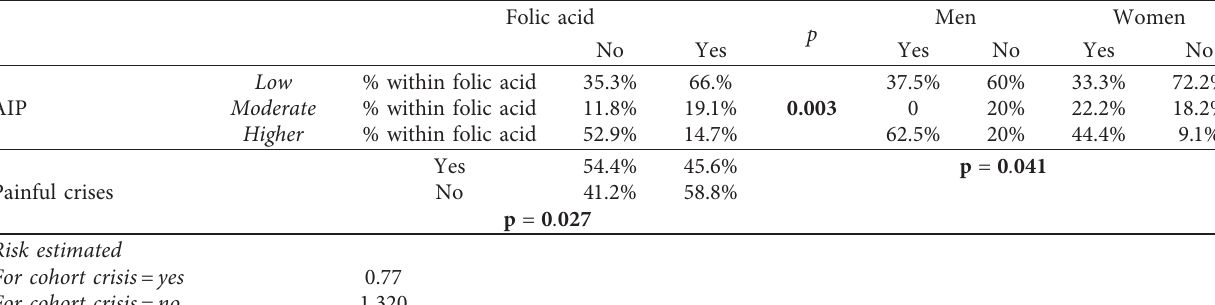
Table 7: Influence of folic acid intake on some AIP, gender, and painful crises. Folic